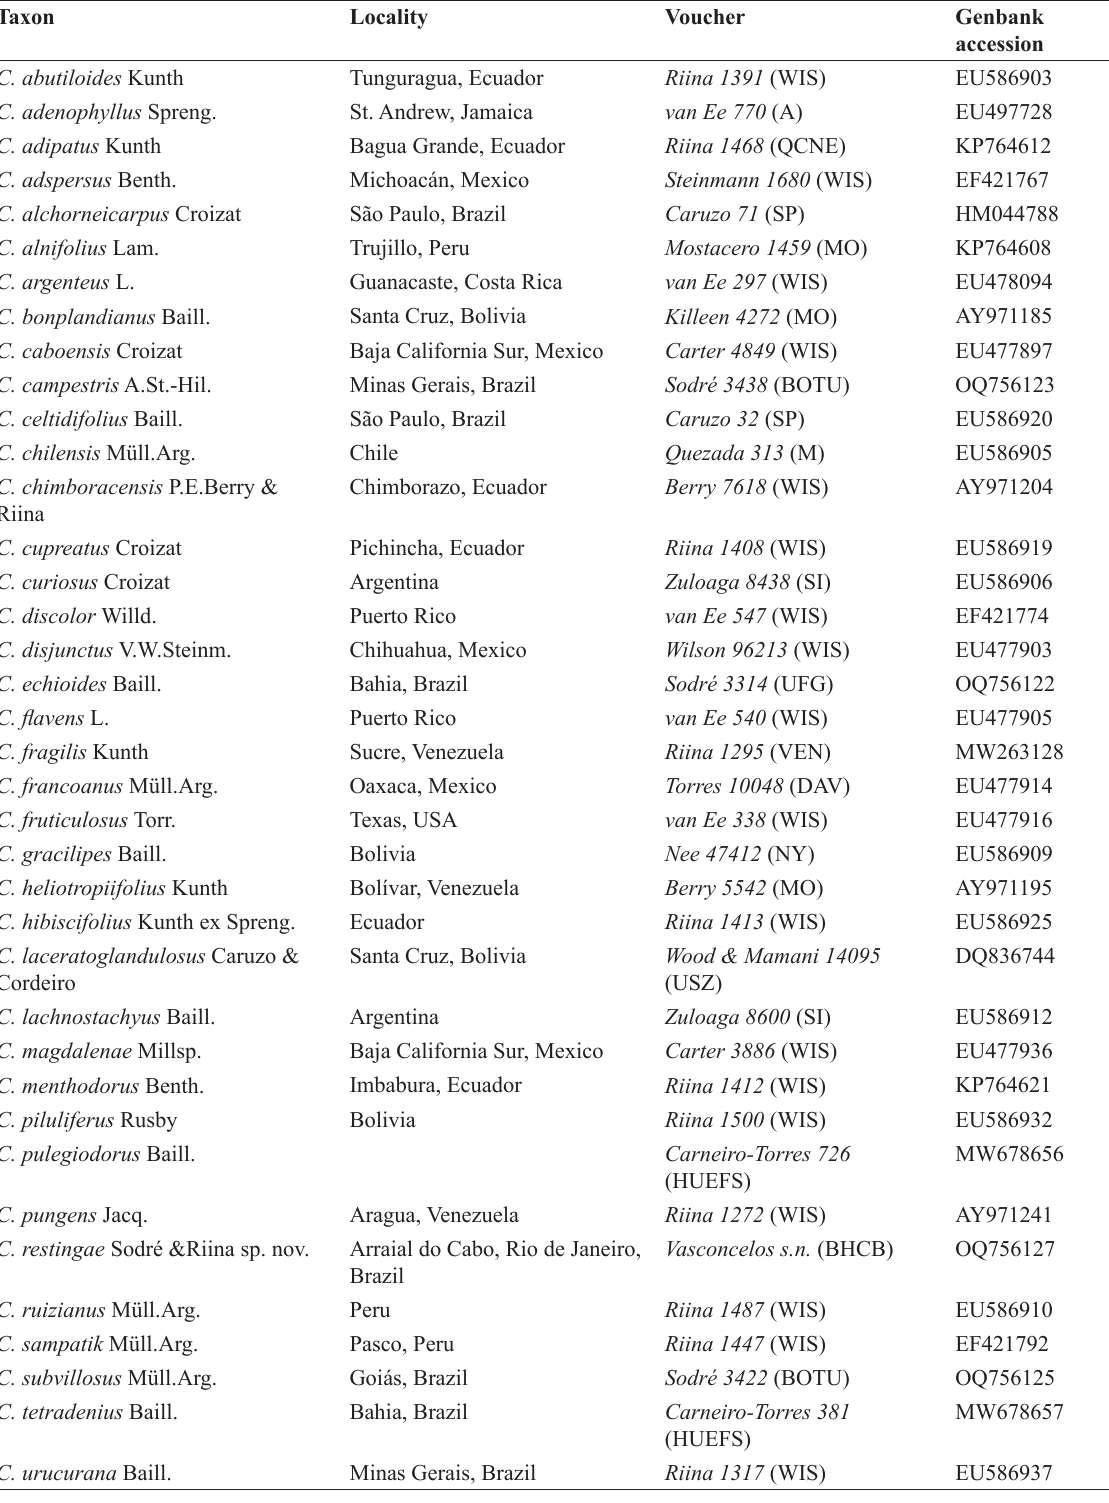
Table 1. List of species of Croton L. used in the phylogenetic analysis with their respective voucher information, locality, and Genbank